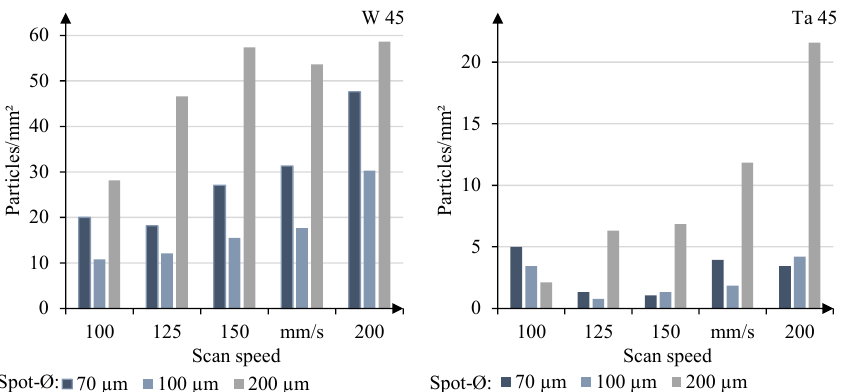
Figure 6. Results of experiment series 2 (see Table 2); constant laser power of 66 W; volumetric energy density scales with scan speed (110–55 J/mm 3 ).